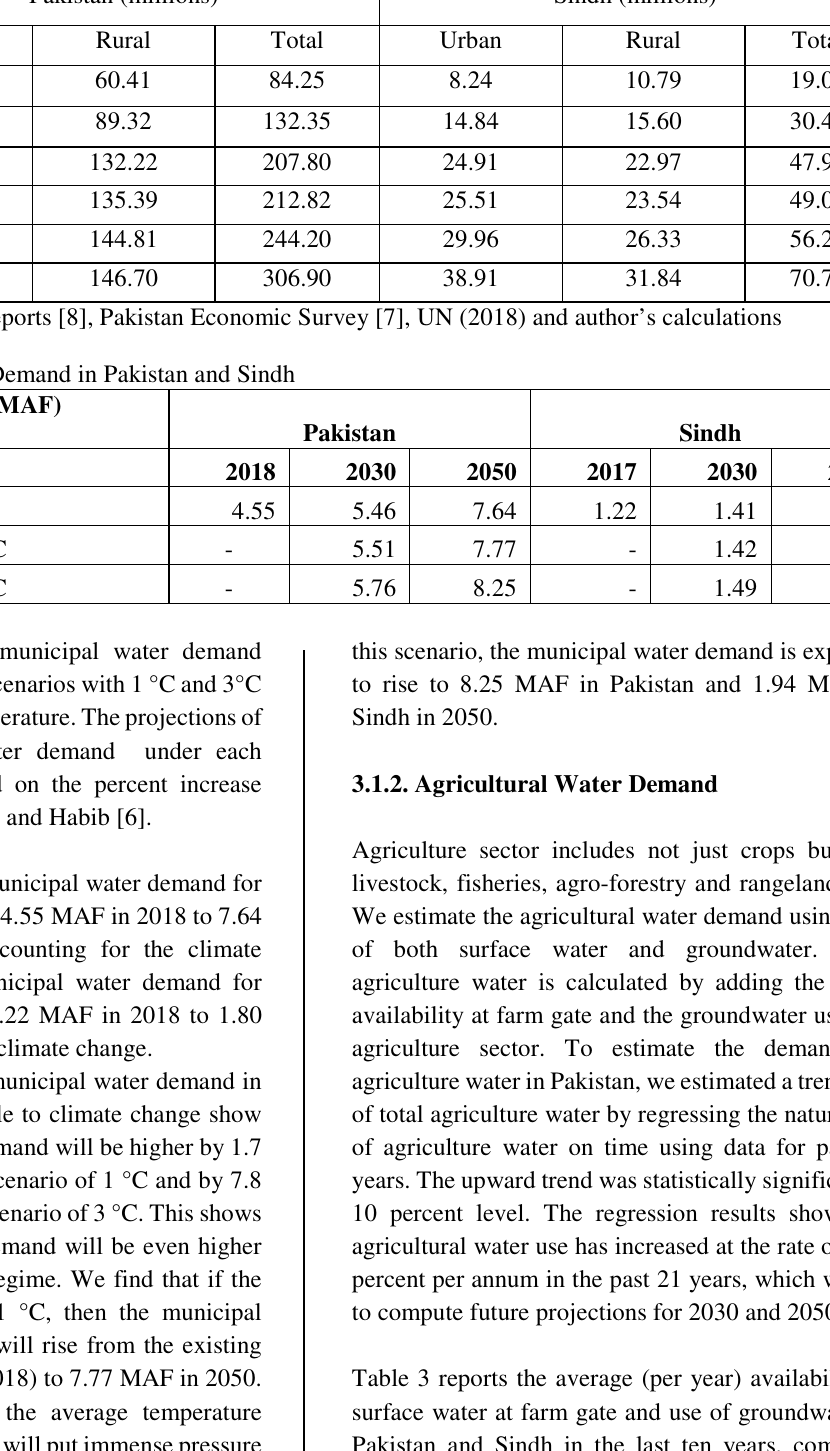
Table 1: Population in Pakistan and Sindh: Urban, Rural and Overall Year Pakistan (millions) Sindh (millions) Urban Rural Total Urban Rural Total 1981